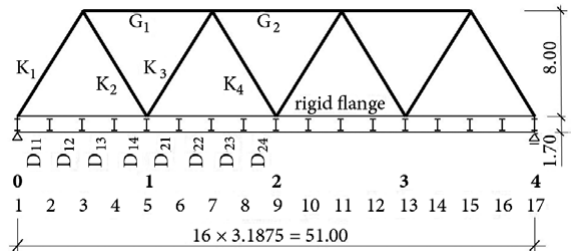
Fig. 7. General view of tested truss girder; flange node (bolded) and cross beam numbering is given Table 1. Cross-sectional characteristics of girder members Model element